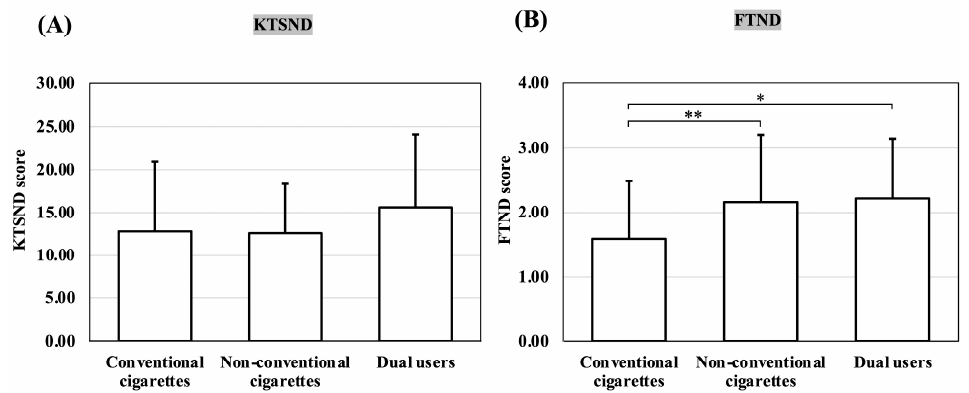
Figure 3. ( A ) Comparison of KTSND scores by smoking device among those who were aware that smoking is a risk factor for COVID-19; ( B ) comparison of FTND scores by smoking device among those who were aware that smoking is a risk factor for COVID-19. All p -values are based on multiple comparisons. *, p < 0.05; **, p < 0.01; KTSND, Kano Test for Social Nicotine Dependence; FTND, Fagerström Test for Nicotine Dependence; COVID-19, coronavirus disease 2019; conventional cigare tt es, cigare tt es smokers; non-conventional cigare tt es, smokers of heated tobacco products or e-cigare tt es; dual users, smokers who use both conventional cigare tt es and non-conventional cigare tt e products.